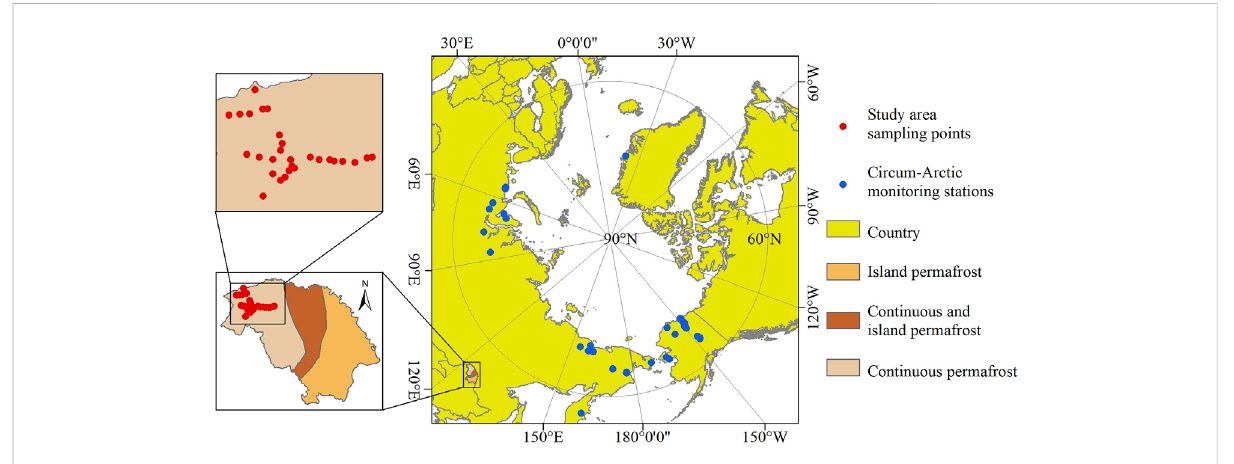
FIGURE 2 Distribution of circum-Arctic monitoring stations and sampling points in the